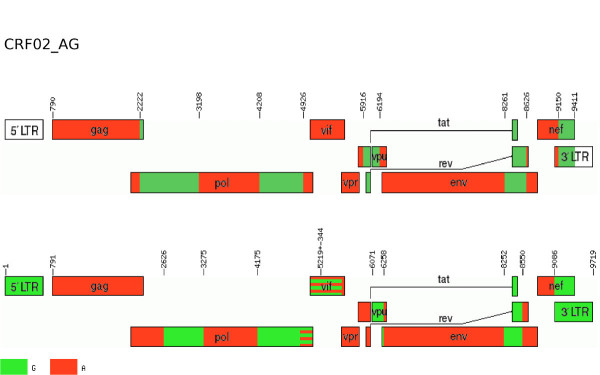
Comparison of genomic recombinations predicted by our jpHMM tool and reported in the literature. In all reference sequences from CRF02 to CRF08 and CRF10 to CRF14, 70% of the jpHMM's predictions were consistent with the published data. As an example, the figure shows the CRF02 recombinant that consists of subtypes A (shown in red) and G (shown in green). Above is the prediction by jpHMM, below the recombination as reported in the literature (see [42]).